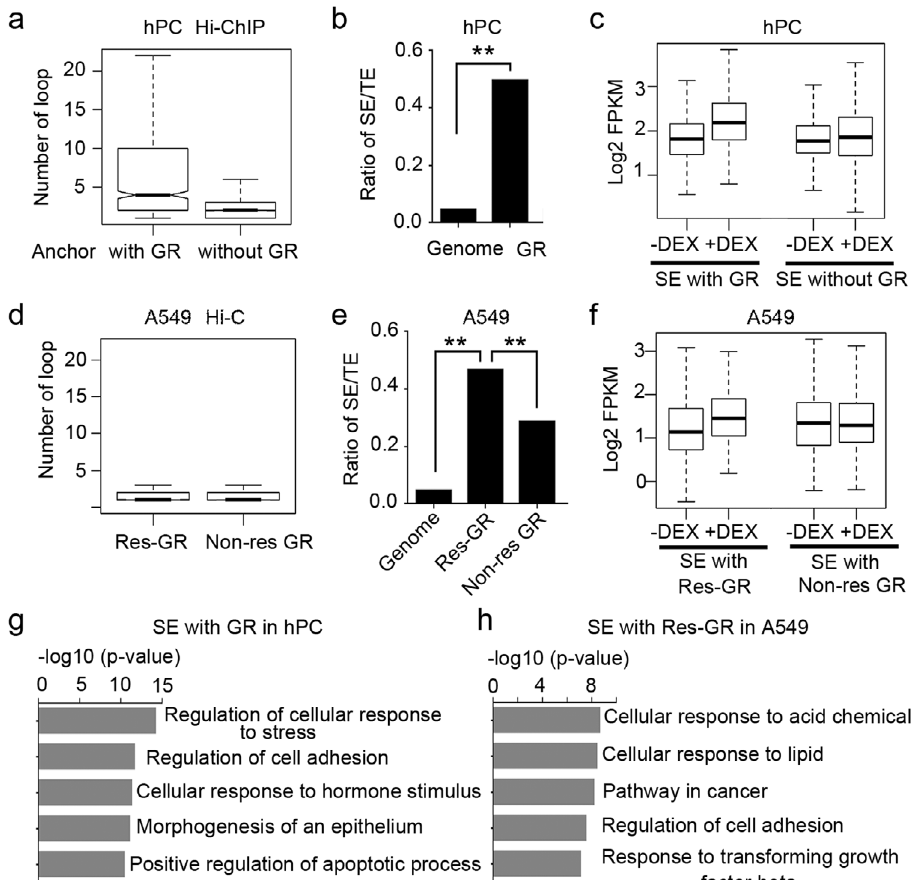
Fig. 4 GR sites are enriched at SEs. a Number of HiChIP loops for anchor with or without GR in hPC. Center line, median; box limits, upper and lower quantiles. b Ratio of SE (super-enhancer) over TE (typical enhancer) in the genome ( N SE = 1409 and N TE = 39,420) and GR-binding regions ( N SE = 242 and N TE = 506) in hPC, p = 0 (chi-square test, ** P < 0.01). c Box plot of H3K27ac signal on SEs with or without GR binding in hPC. Center line, median; box limits, upper and lower quantiles. d Number of Hi-C loops for anchor with or without GR in A549. Center line, median; box limits, upper and lower quantiles. e Ratio of SE (super-enhancer) over TE (typical enhancer) in genome ( N SE = 1189 and N TE = 24,873), responsive GR (res-GR, N SE = 390 and N TE = 724), and non-responsive GR (non-res-GR, N = 1090 and N = 3719) regions in A549, p = 0, p = 0 (chi-square test, ** p < 0.01). f Box plot of SE TE Res Nonres H3K27ac signal on SEs with Res or non-res-GR binding in A549. Center line, median; box limits, upper and lower quantiles. g , h Top GO terms for the genes interacted with GR-associated SEs in hPC or Res-GR-associated SE in